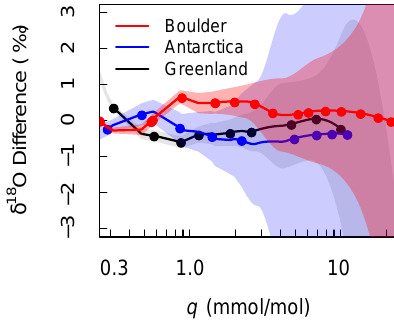
Figure 3. Mauna Loa concentration-dependence characterizations for three different isotopic standards named in the legend. Curves – fit with a local regression – are shown as differences from the con- centration dependence obtained when data from all three standards are considered and are depicted as a function of q – the water vapor volume mixing ratio – on a log scale. Solid circles represent the q values at which calibration points were measured. Prediction errors are represented by shading.